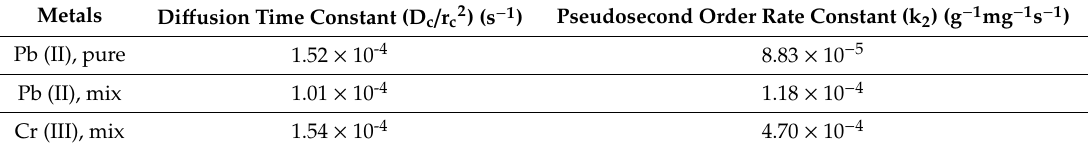
Table 3. Kinetic model fitting parameters for adsorption